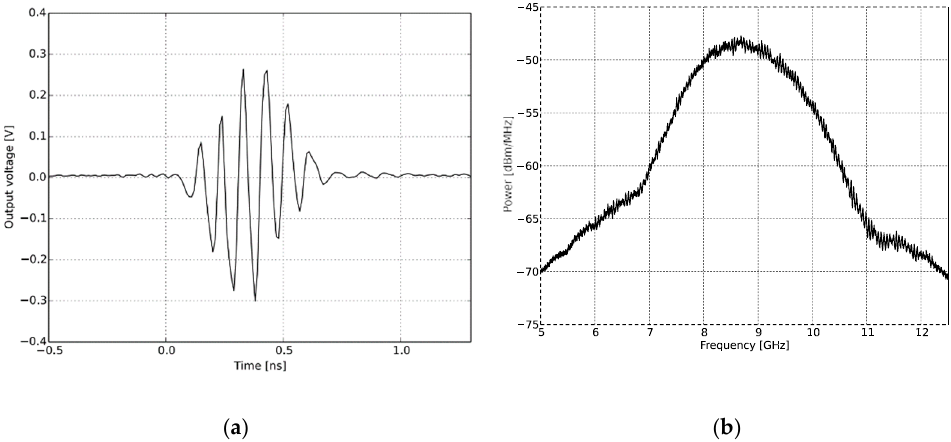
Figure 9. The transmitted pulse shape and frequency spectrum of IR-UWB radar for PGSelect = 10; ( a ) transmitted signal in the time domain and; ( b ) transmitted signal pulse in the frequency domain.